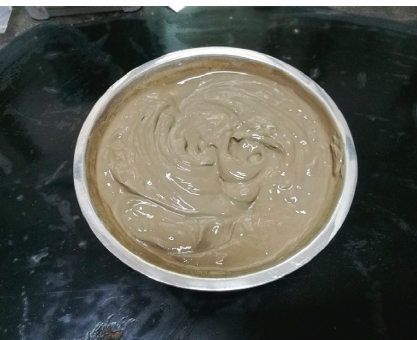
Figure 1: Dredged material.